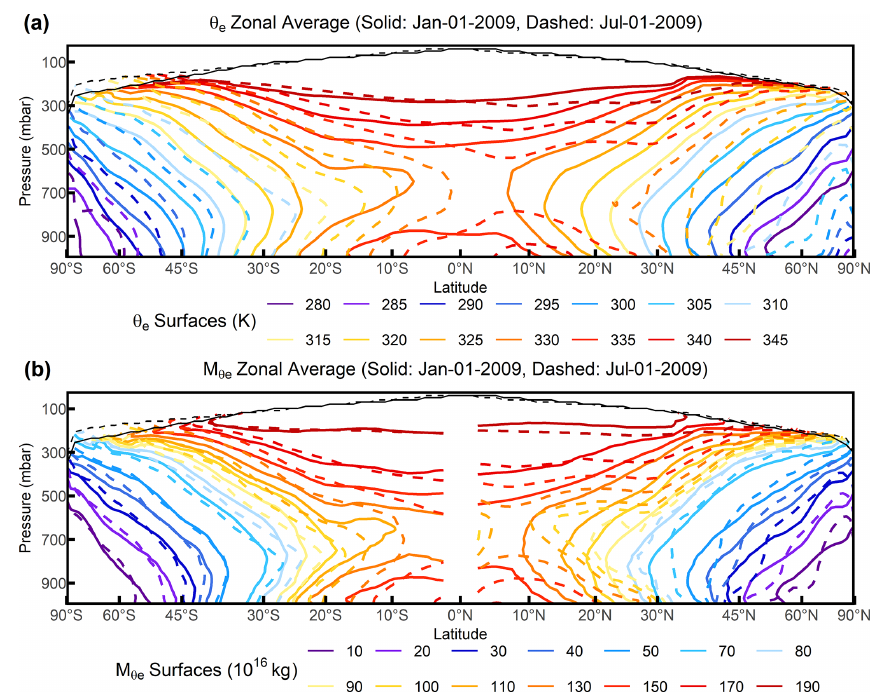
Figure 2. Snapshot of the distribution of (a) zonal average θ e surfaces on 1 January 2009 (solid lines) and 1 July 2009 (dashed lines) and (b) zonal average M θ surfaces on 1 January 2009 (solid lines) and 1 July 2009 (dashed lines). The zonal average tropopause is also shown e here for 1 January 2009 (solid black line) and 1 July 2009 (dashed black line). θ e , M θ